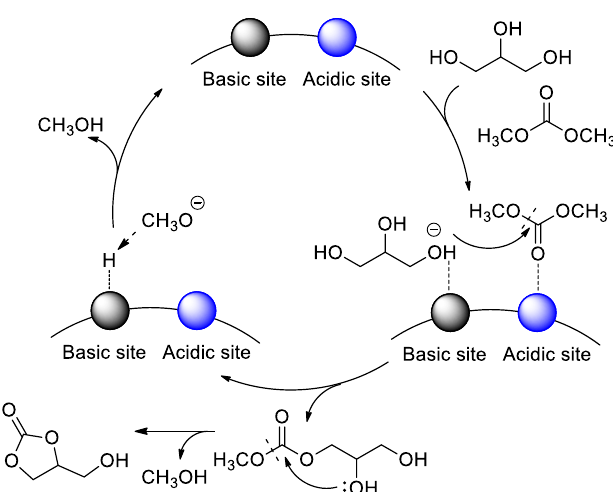
Figure 7. Plausible reaction mechanism for bifunctional catalysis in the transesterification of glycerol, (reprinted with permission from Reference [52], Elsevier).